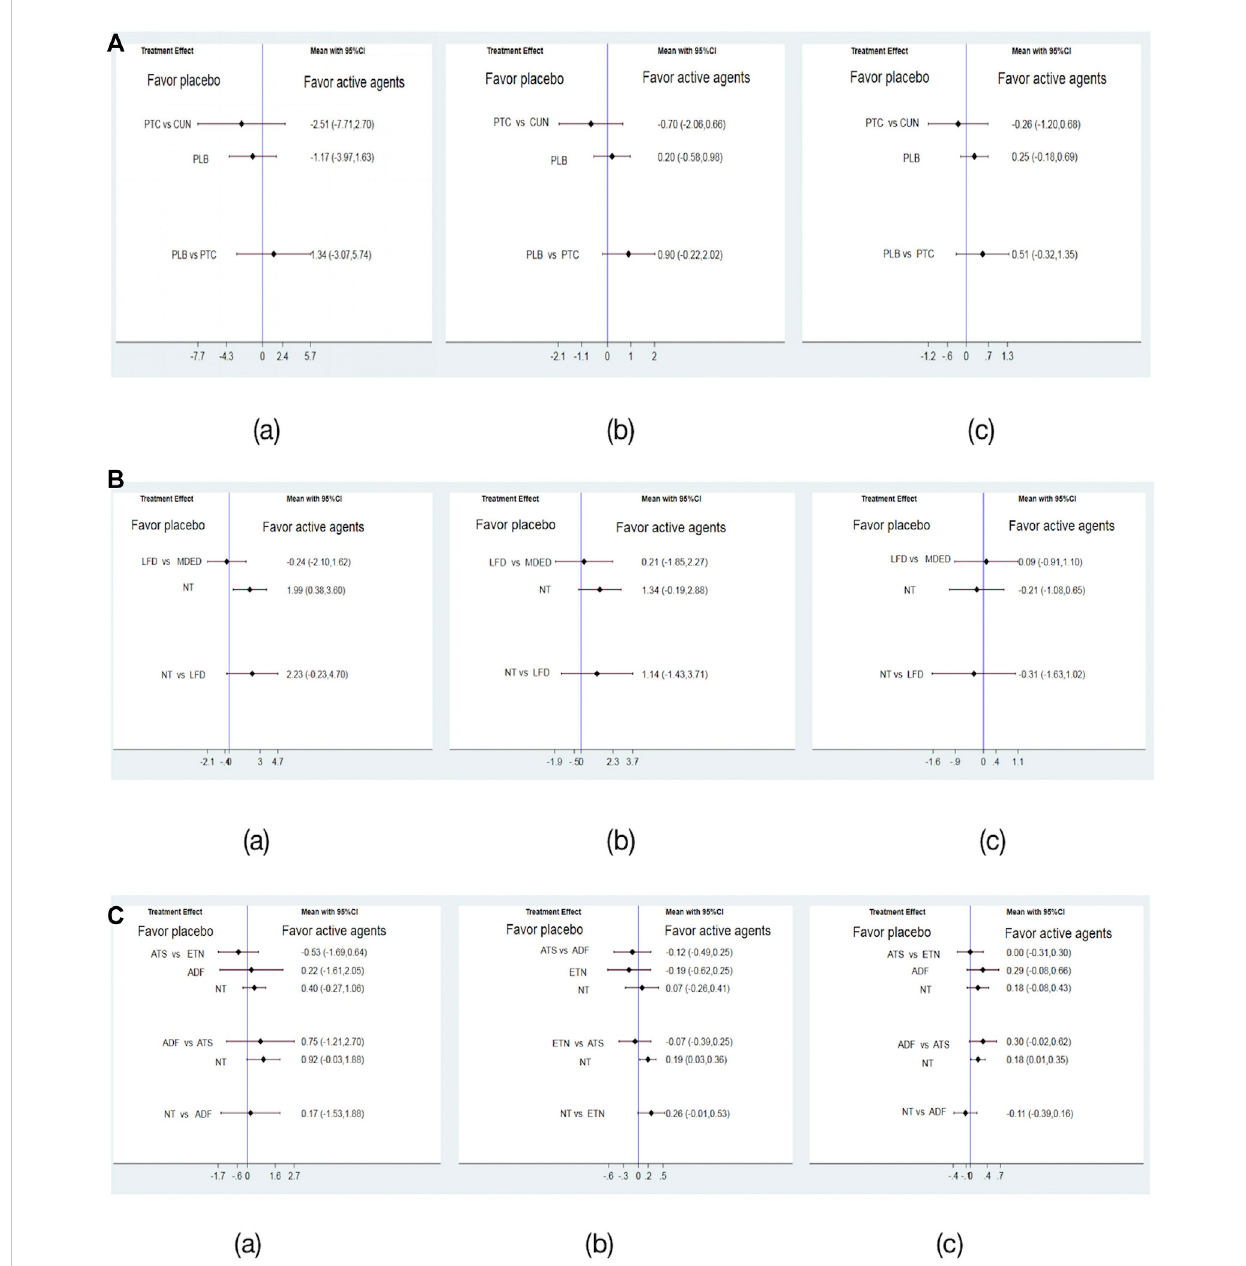
FIGURE 3 (A) Forest plot effcacy of medication with placebo (PLB), (a)Forest plot effcacy of curcumin (CUN) and probiotics (PTC) with placebo in improving alanine aminotransferase (ALT), (b)Forest plot effcacy of curcumin (CUN) and probiotics (PTC) with placebo (PLB) in improving total cholesterol (TC), (c) Forest plot effcacy of curcumin (CUN) and probiotics (PTC) with placebo (PLB) in improving low-density lipoprotein cholesterol (LDL). (B) Forest plot effcacy of diet with control, (a) Forest plot effcacy of mediterranean diet (MDED) and low-fat diet (LFD) with not have any type of treatment (NT) in improvingalanineaminotransferase(ALT),(b)Forestploteffcacyofmediterraneandiet(MDED)andlow-fatdiet(LFD)withnothaveanytypeoftreatment (NT) in improving total cholesterol (TC), (c) Forest plot effcacy of mediterranean diet (MDED) and low-fat diet (LFD) with not have any type of treatment (NT)inimprovinglow-densitylipoproteincholesterol(LDL). (C) Forestploteffcacyoflifestylewithcontrol,(a)Forestploteffcacyofexercisetraining(ETN), accept theoretical suggestions (ATS) and alternate-day fasting (ADF) with not have any type of treatment (NT) in improving alanine aminotransferase (ALT), (b) Forest plot effcacy of exercise training (ETN), accept theoretical suggestions (ATS) and alternate-day fasting (ADF) with not have any type of treatment(NT)inimprovingtotalcholesterol(TC),(c)Forestploteffcacyofexercisetraining(ETN),accepttheoreticalsuggestions(ATS)andalternate-day fasting (ADF) with not have any type of treatment (NT) in improving low-density lipoprotein cholesterol